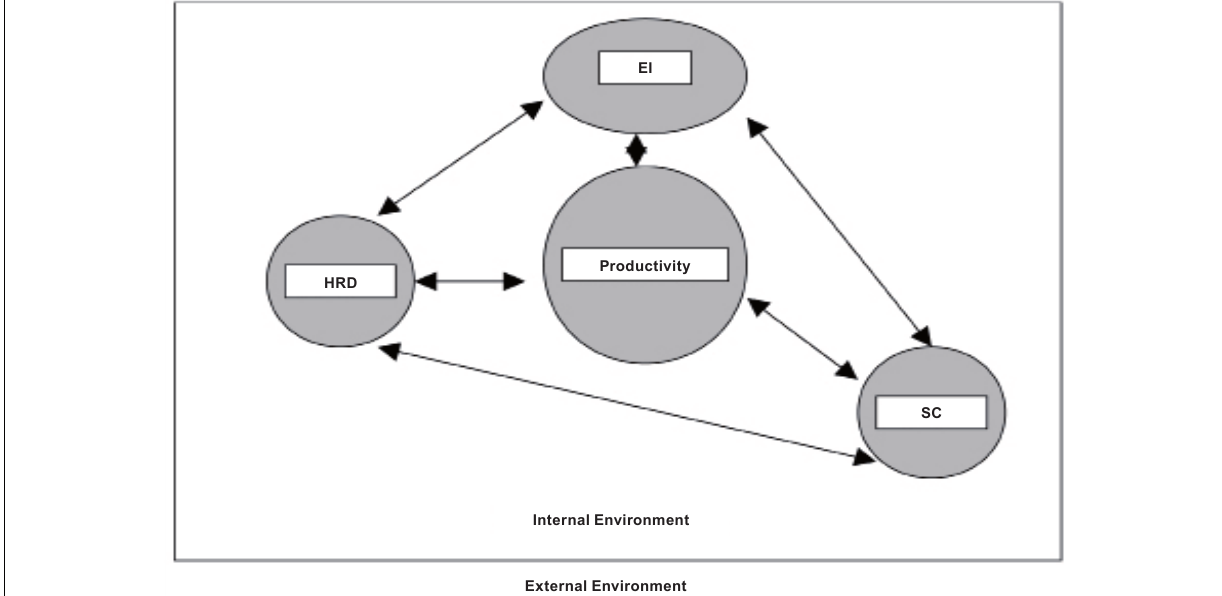
FIGURE 1 The relationship between human resource development, emotional intelligence, social capital and productivity